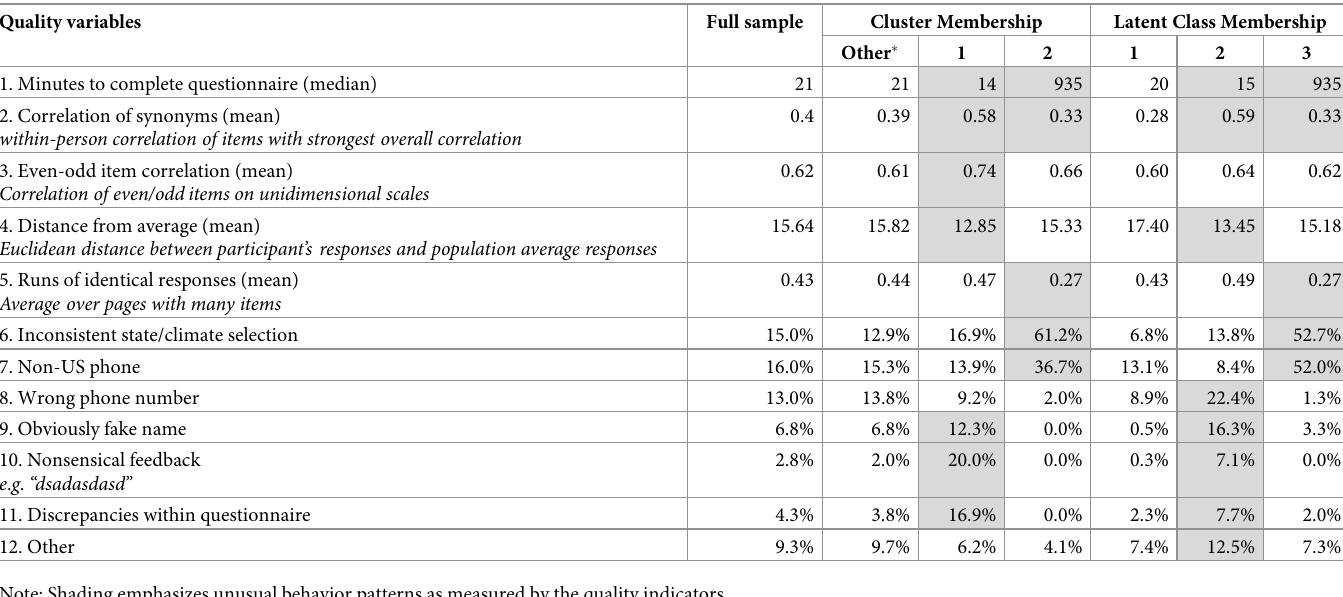
Table 2. Quality variables by cluster membership and predicted latent class.